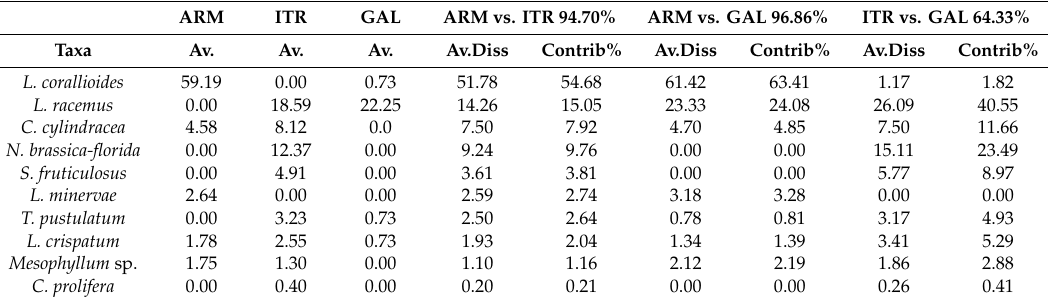
ARM ITR GAL ARM vs. ITR 94.70% ARM vs. GAL 96.86% ITR vs. GAL